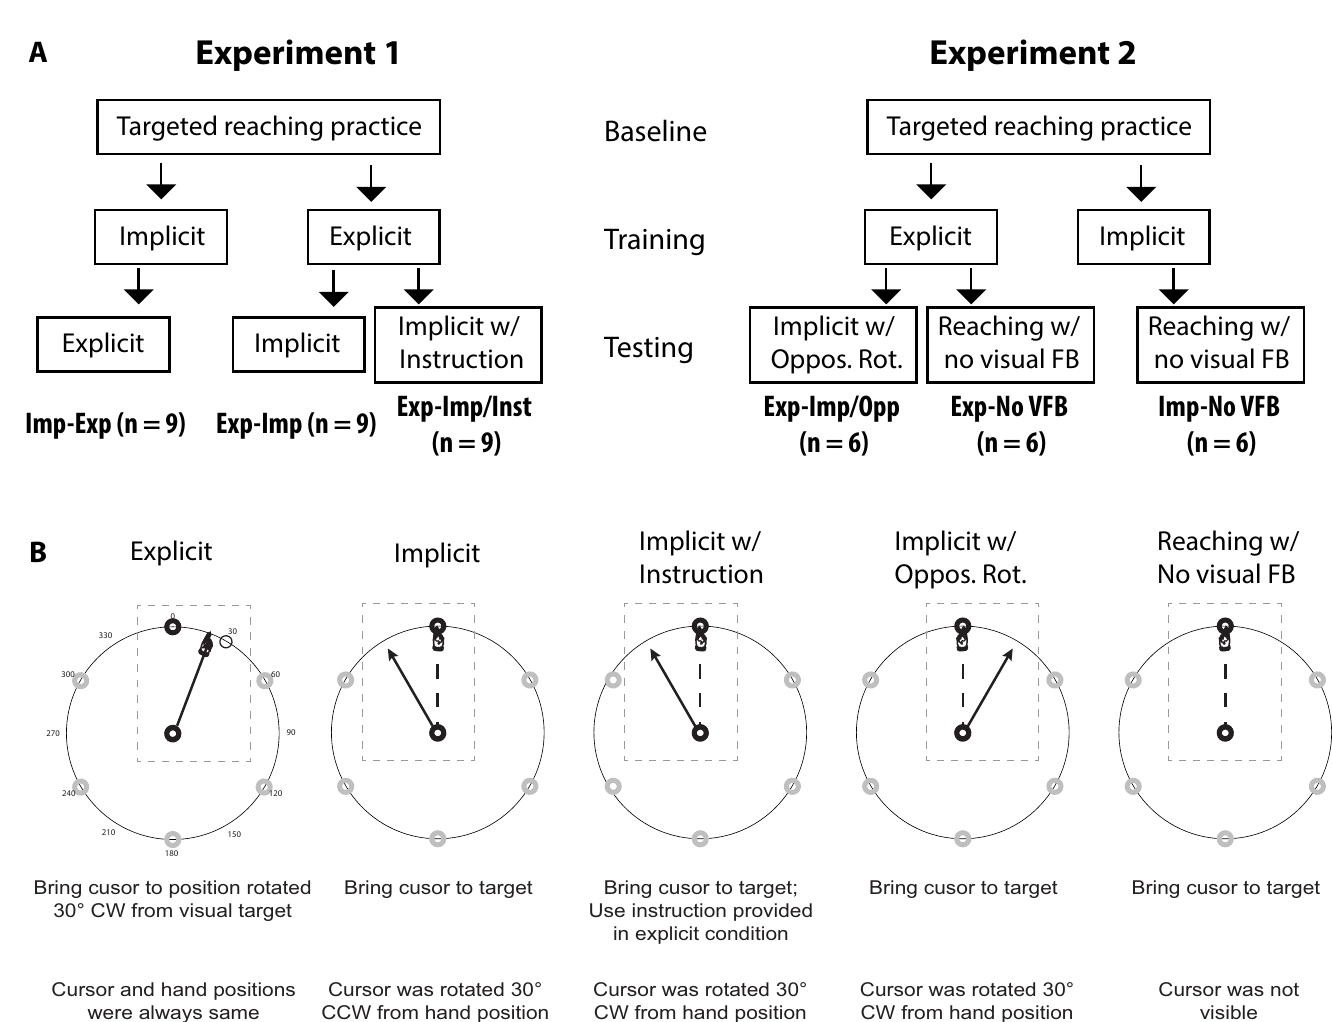
Fig 2. Characteristics of subject groups and conditions. (A) Conditions provided for each subject group during three experimental sessions. (B) Statements in first row describe task for each condition. In explicit condition, subjects reached toward imaginary targets that were rotated 30 degrees CW about start position from visible targets. In implicit condition, subjects reached toward targets under condition in which visual display was rotated 30 degrees CCW about start position. In implicit w/ instruction condition, subjects reached toward targets under condition in which visual display was rotated 30 degrees CCW about start position, and were told to use instruction provided during explicit learning. In implicit w/ Oppos. Rot. condition, subjects reached toward targets under condition in which visual display was rotated 30 degrees CW about start position. In reaching w/ no visual FB condition, subjects reached toward visible targets without receiving visual feedback of hand position. Statements in second row describe the cursor-hand mapping arrangement for each condition. Solid black arrows indicate cursor movement directions; broken black lines with hand sign at the end indicate hand movement directions. Landmark values (0–330) were only visible in